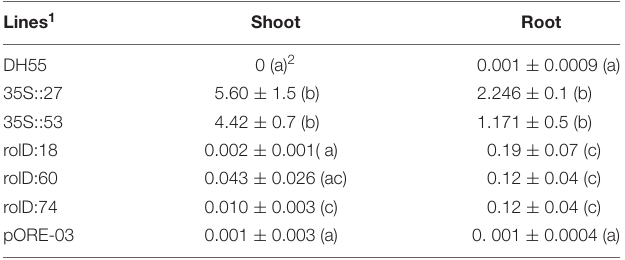
TABLE 1 | Expression of the ACC deaminase ( acdS ) gene in transgenic camelina. Lines 1